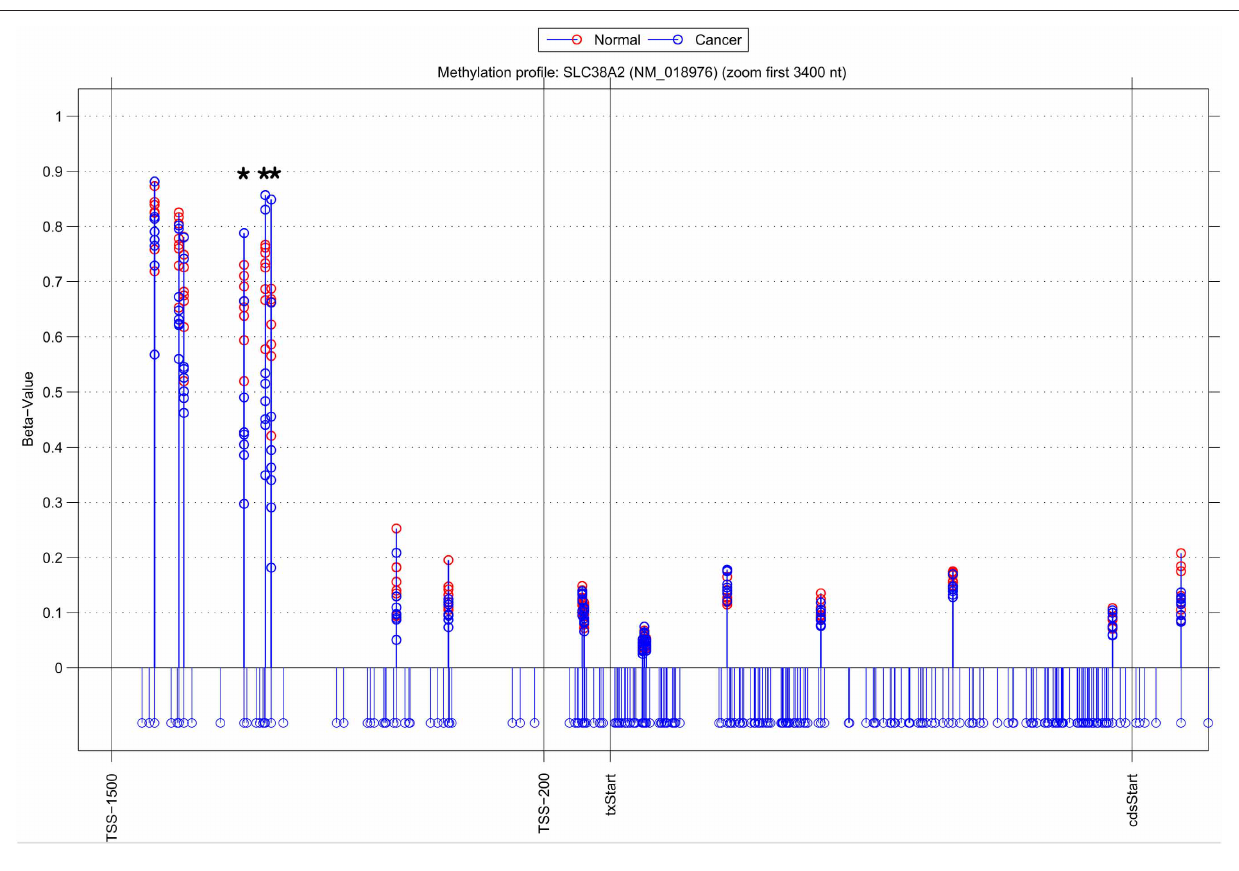
FIGURE 5 | Methylation profile of gene SLC38A2. NIMBL-gene output showing a zoomed region of the genomic location of the gene SLC38A2 displaying 18 out of 20 CpG sites associated with this gene on the array. The stems below the x-axis correspond to all CpG sites located in this region.